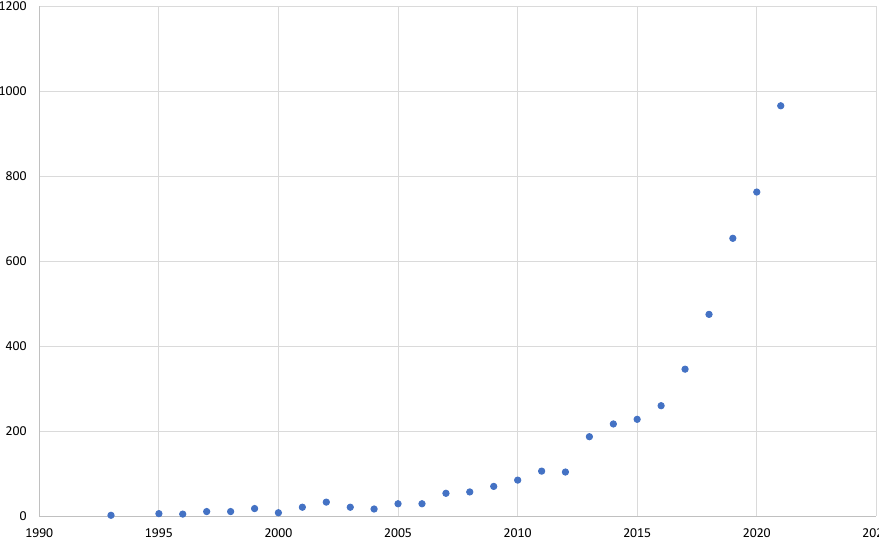
Figure 1. Scopus articles referring to augmented reality per year